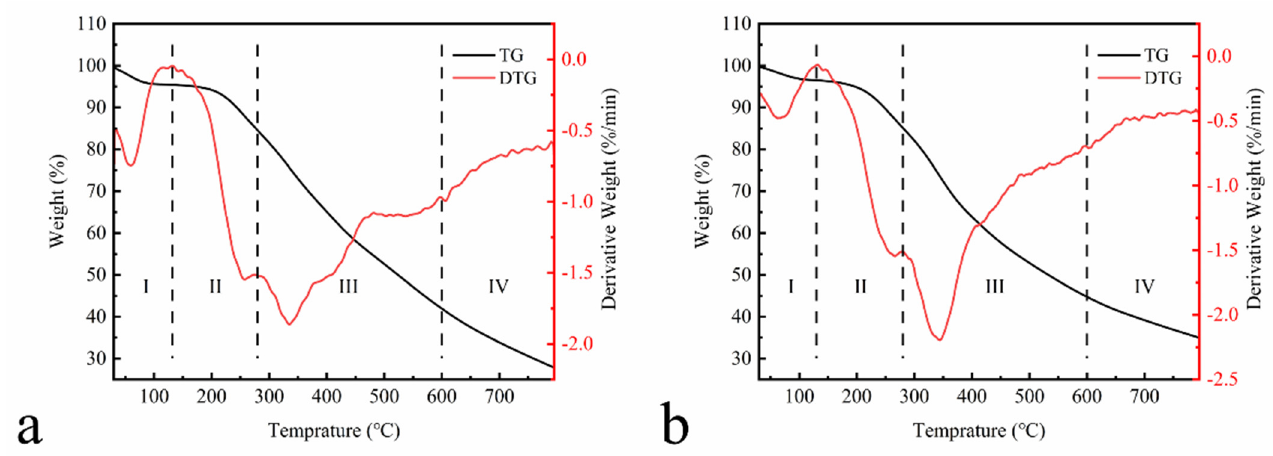
Figure 5. Thermogravimetric analysis of ( a ) EHL and ( b ) HEHL in the temperature range of 30–795 °C with a heating rate of 10 °C/min under nitrogen atmosphere (10 mL/min).